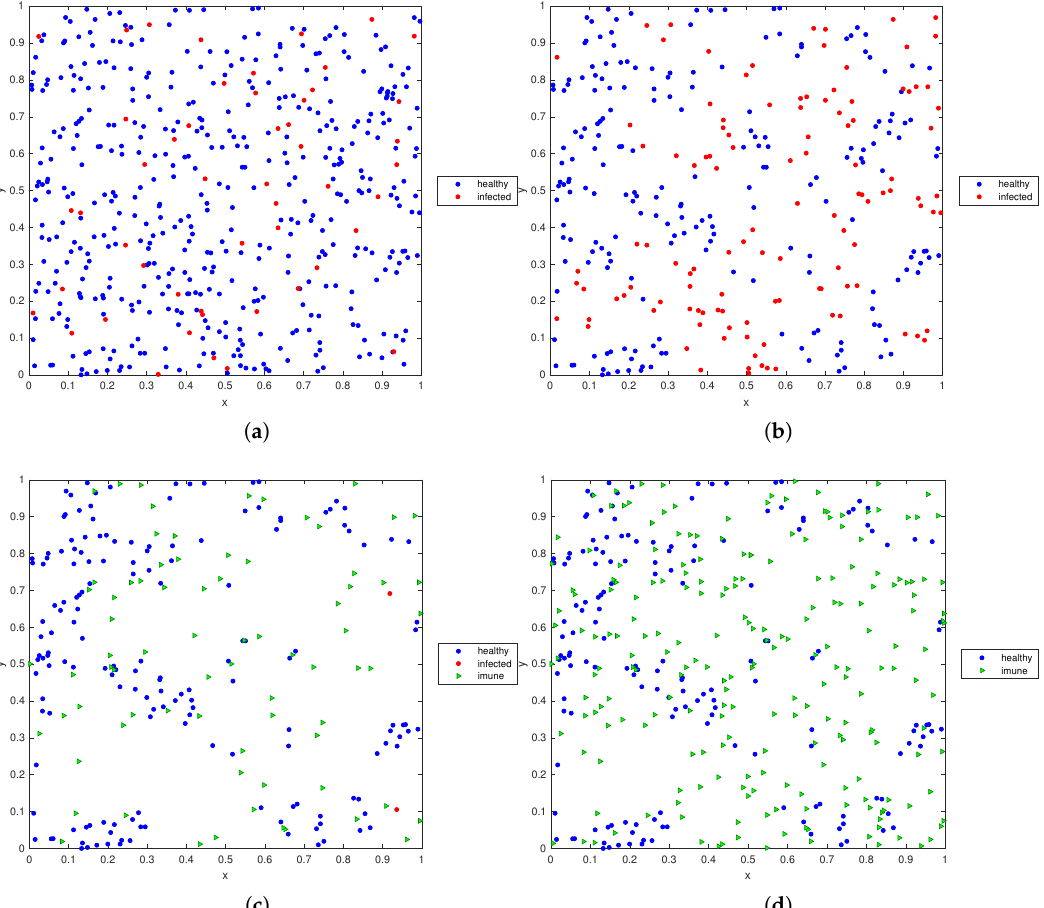
Figure 10. State of the SW space occupation by ‘healthy’, ‘infected’ and ‘immunized’ individuals for: ( a ) t = 1, ( b ) t = 5, ( c ) t = 10, ( d ) t = 20 ( N = 500, n i = 50, D = 0.05, δ = 0.1, p 1 = 0.1, p 2 = 0.9, p 3 = 0.7, p 4 = 0.05, p 5 = 0.02, α = 2 and N h → ∞